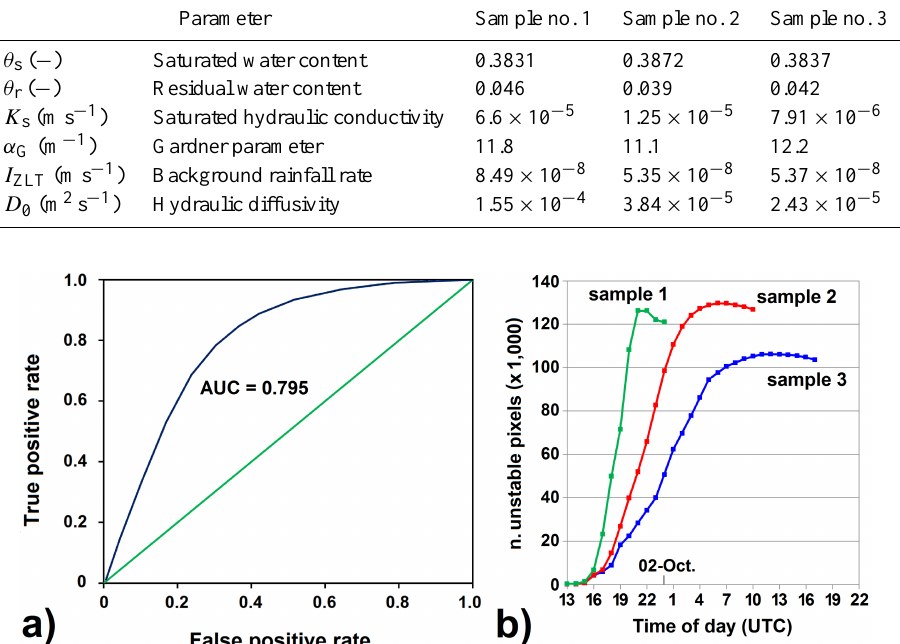
Table 5. Parameters derived from HYDRUS 1-D simulations, considering the grain size characteristics of the three soil samples.